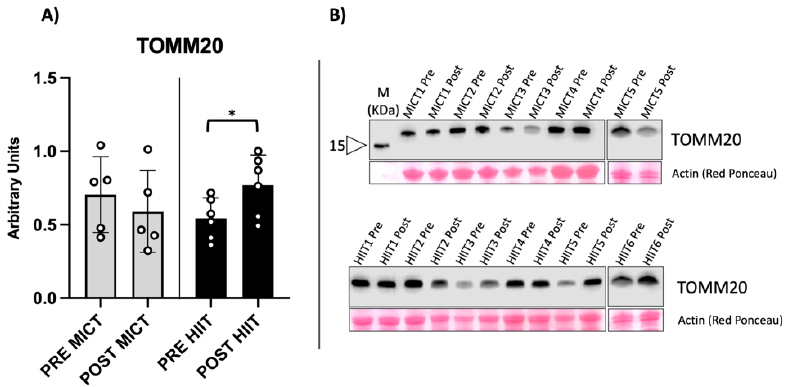
Figure 1. Evaluation of TOMM20 protein content as mitochondrial mass biomarker. ( A ) The graph shows a statistically significant increase in HIIT and no significantly variation in MICT. ( B ) Representative immunoblot obtained from the vastus lateralis of an obese subject. Western blot results are derived from two separate blots as shown in the figure. * = p ‐ value < 0.05 ( p = 0.049 in HIIT).